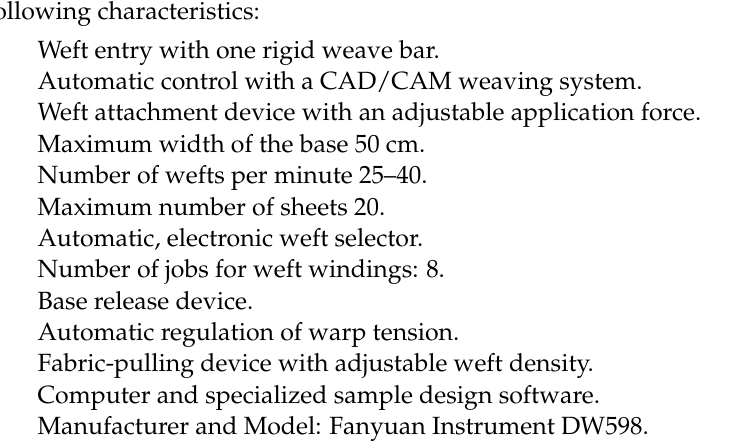
Figure 3. Cross-section of a 3D-woven fabric, marked “1pp” (magnification 20×).